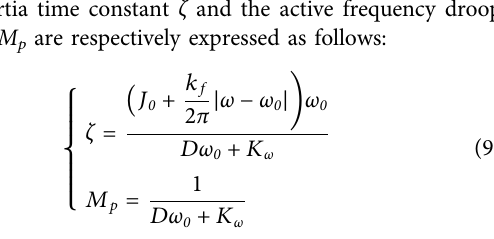
current and the output voltage are adaptive due to the differential capacitive current. Also, the inner current loop improves the load inverter capacity. The block diagram of the voltage and current double loop control is illustrated in Figure 4 ; (Zhang and Li, 2015).where U* odq is input voltage signal, i is the input current of the inner loop, k is the gain coef fi cient, k p represents the inverter transfer function, and U 0 is the output voltage of the inverter. C and L are fi lter capacitance and inductance, respectively. i c and i L are the currents of the capacitor and inductor separately. i abc is the bus current microgrid and U odq represents the output voltage signal.